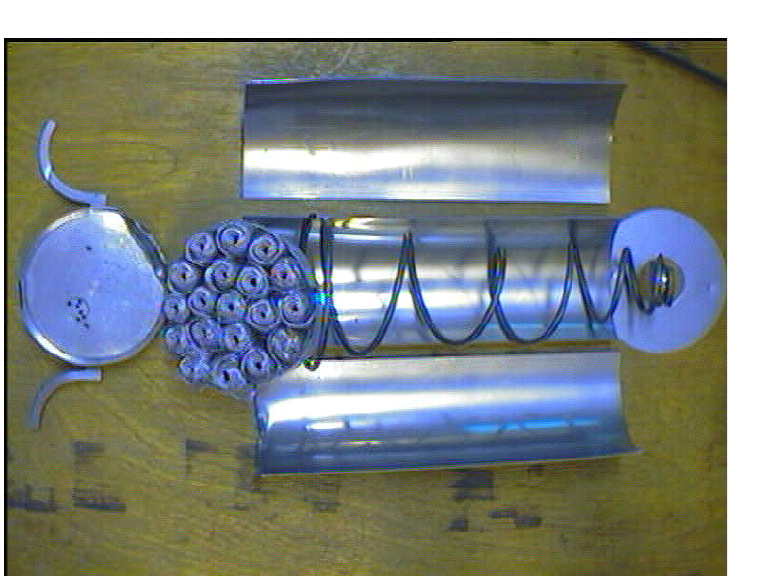
Figure 4 – Parts of an open cluster bomblet with spools and an ejection